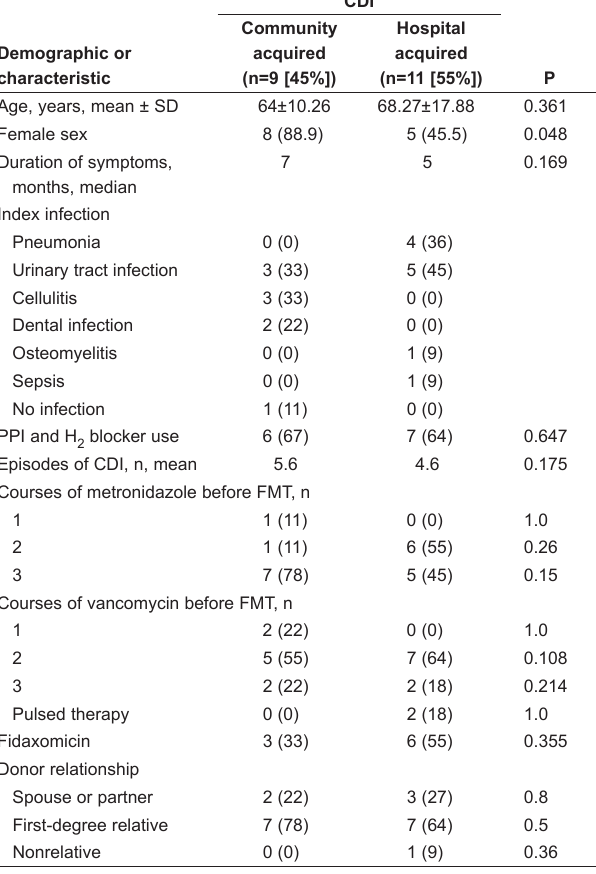
TAble 2 Demographics and characteristics in community- and hospital-acquired Clostridium difficile infection